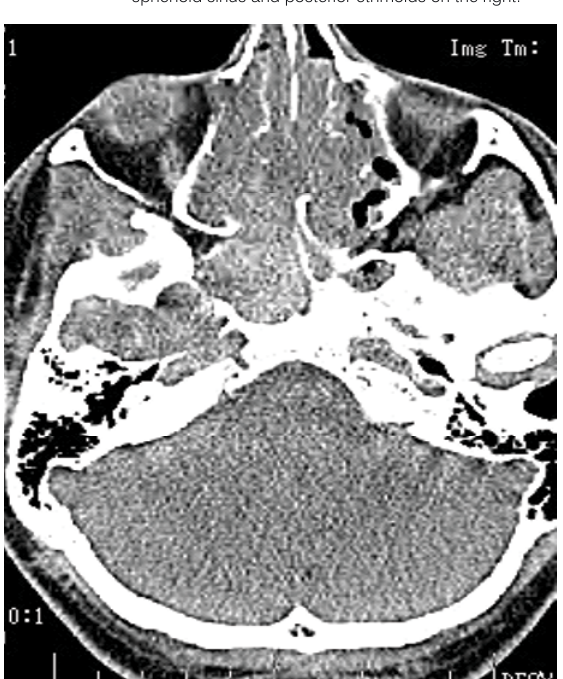
Figure 2. MRI of paranasal sinuses and orbits, coronal section: Optical neuritis on both sides and partial opacity of the ethmoids, predominantly on the